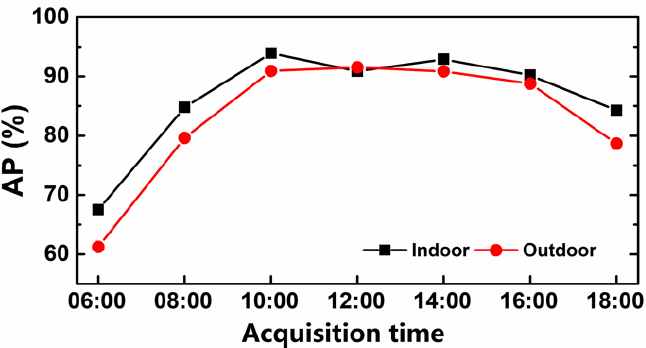
Figure 11. Average detection accuracy for leaves of different plants. Figure 11. Average Detection Accuracy of Eggplant Leaves in Different Time Periods.